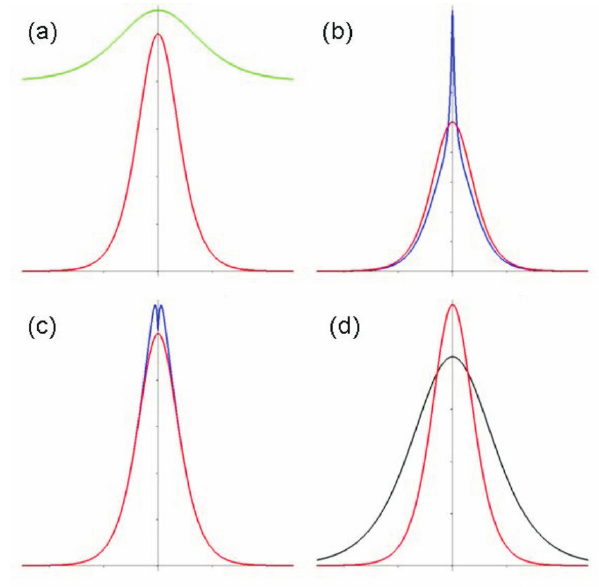
Fig. 1. Transient and trapped ions in the model of thin anisotropic current sheet. Fig. 2. Sketches of a typical model sheet. (a) Current density